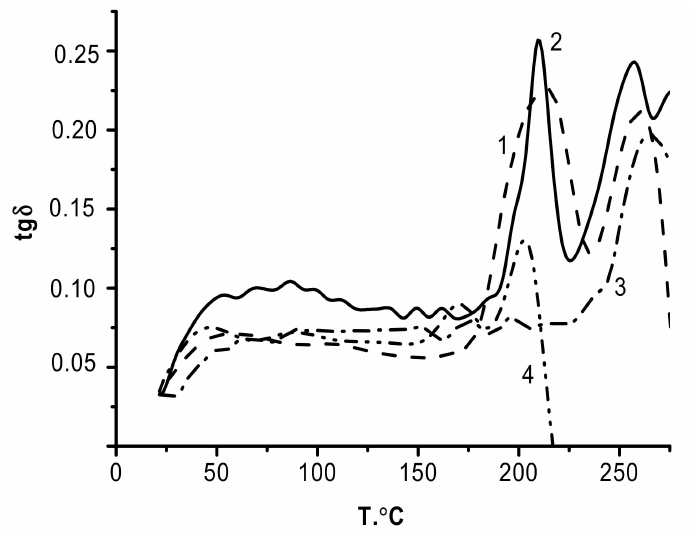
Figure 8. Temperature dependence of the mechanical loss tangent: 1, CS s –PEC ALG –ALG; 2, CS b – PEC ALG ; 3, CS b ; and 4,